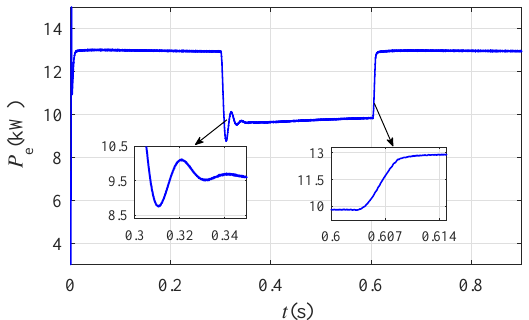
Figure 8. Variation of active power under ACB control